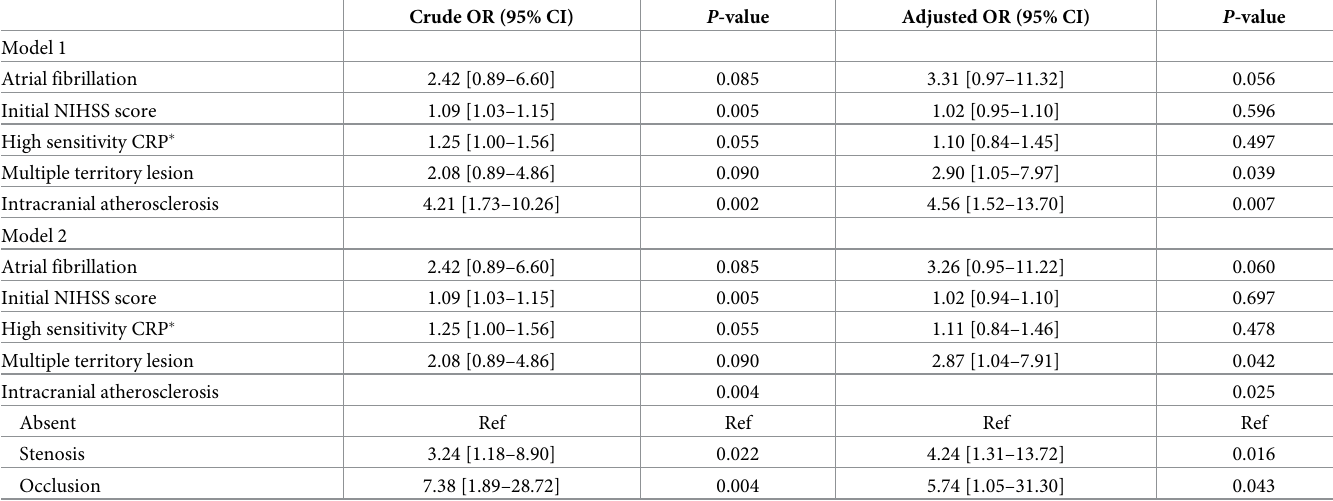
Table 2. Multivariable logistic regression for possible predictors of early neurological